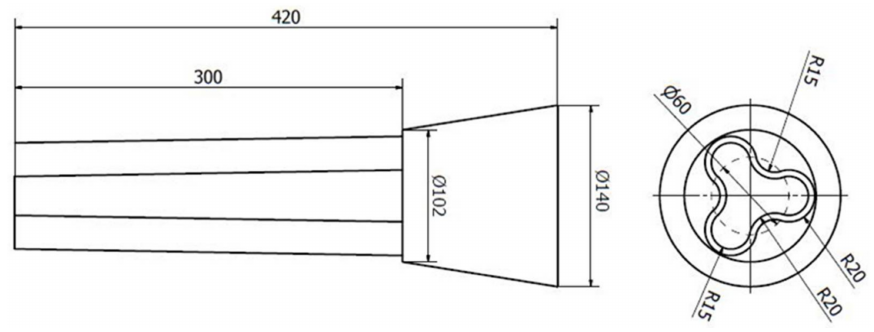
Figure 1. Clover-like sample according to Polish norm